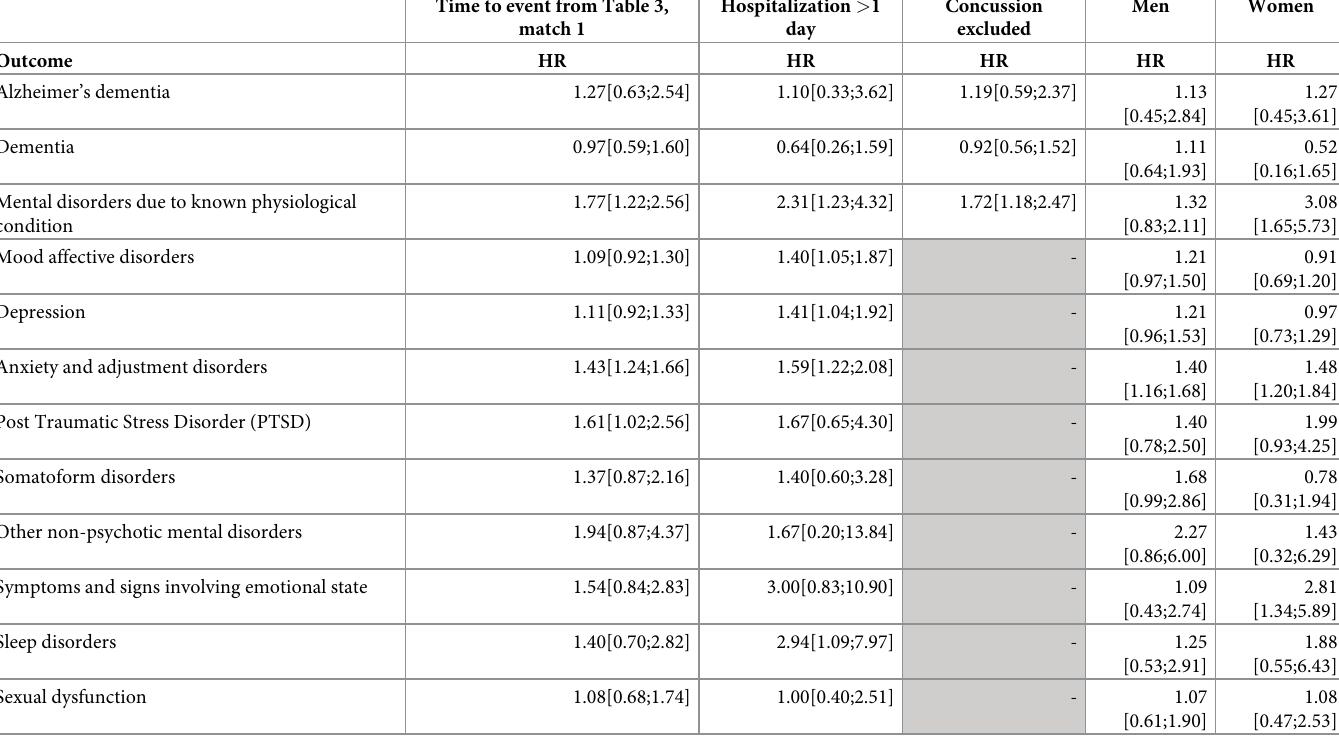
Table 3. Sensitivity analyses (electrical injuries matched with dislocation/sprain